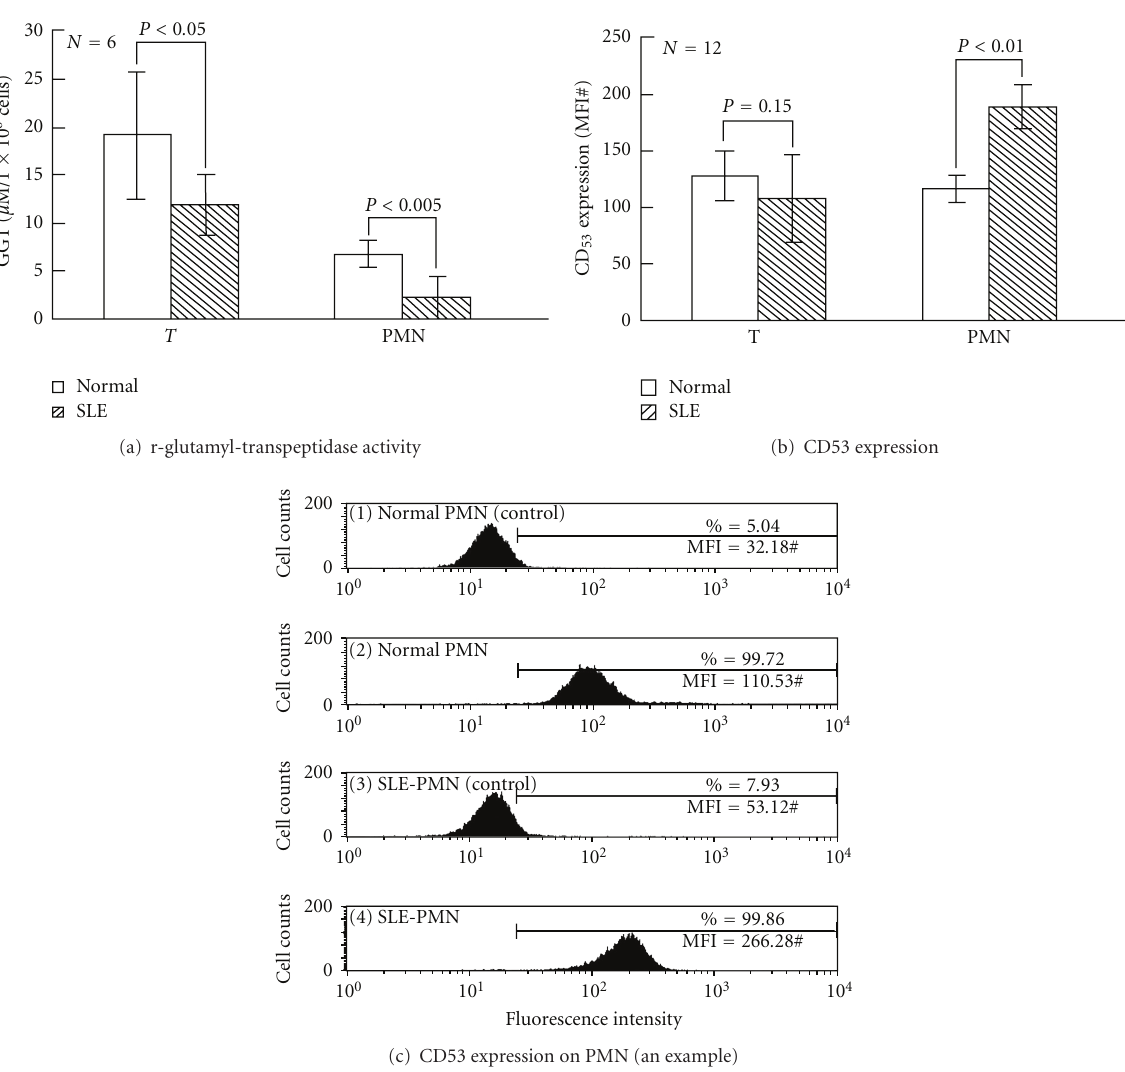
Figure 6: Comparison of γ -glutamyl-transpeptidase (GGT) enzyme activity and CD53 expression in T and PMN of normal and SLE patients. (a) GGT enzyme activity. (b) Surface CD53 expression. (c) A typical case demonstrating surface CD53 expression on normal and SLE-PMN using flow cytometry. A similar tendency was seen in the cells of an additional 3 normal individuals and 3 SLE